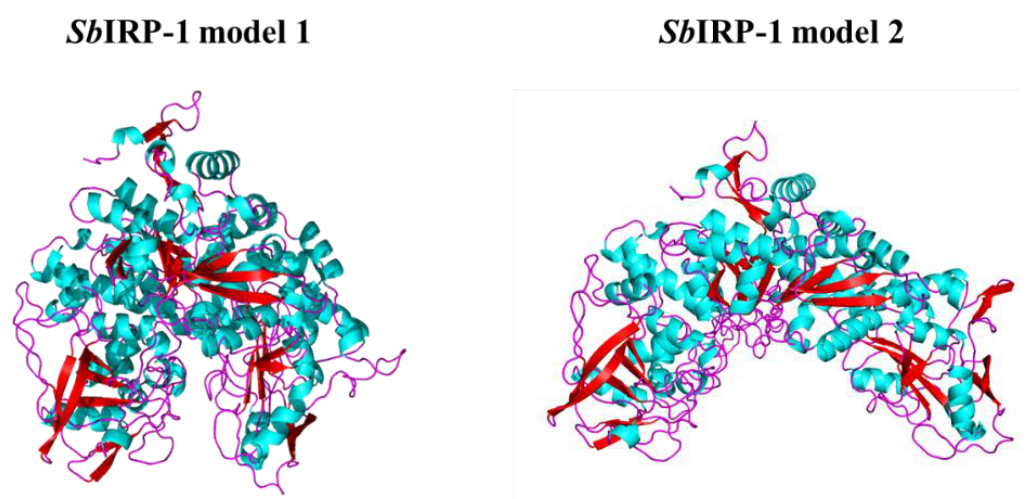
9 of 17 Figure 2. Multiple sequence alignment of Sb IRP-1 with other IRP1s from various species. The amino acid number above the sequence refers to Sb IRP-1. Asterisks represent active sites in the aconitase domains. The dashed amino acid fragments indicate putative RNA binding regions. Red shading regions indicate similar (consensus >70%) amino acids. The species (access number) in- clude Crassostrea virginica (XP_022311890.1), Mizuhopecten yessoensis (XP_021340677.1), Mus muscu- lus (NP_031412.2), Rattus norvegicus (NP_059017.2), Homo sapiens (NP_001265281.1), Danio rerio (NP_001030155.1). The three-dimensional structure of Sb IRP-1 was calculated using the SWISS-MODEL program. The results revealed two alternative conformations of Sb IRP-1; model-template alignments showed that Sb IRP-1 (amino acids 5 – 941) shared 72.57% sequence identity